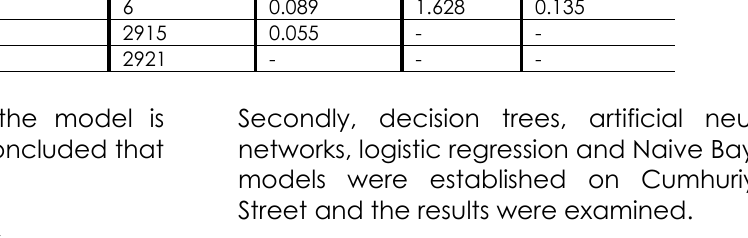
Table 13. Model comparison fit statistics.